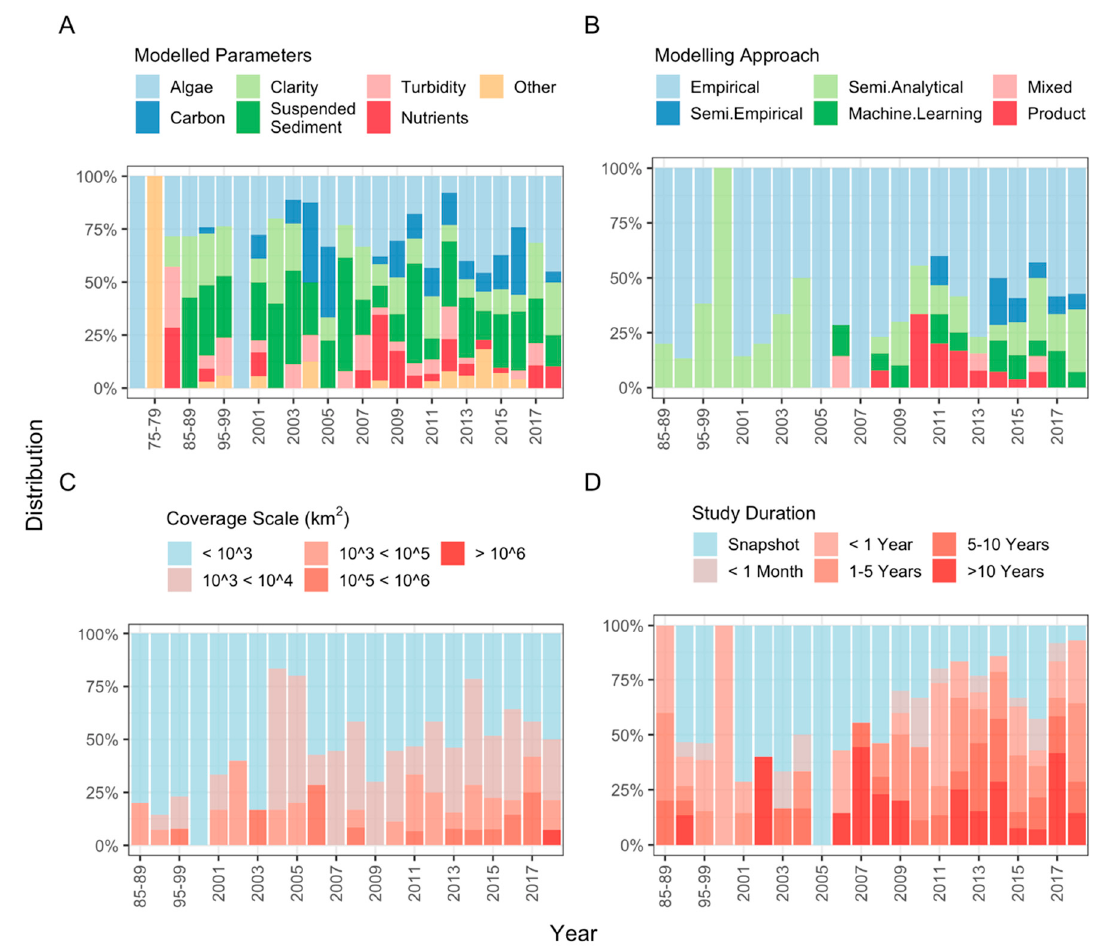
Figure 5. Temporal distributions of modelled parameters ( A ), modelling approach ( B ), study spatial scale ( C ), and study temporal scale ( D ). Results for 1975–1999 are reported in five-year windows due to the relatively small number of studies published during this time period.